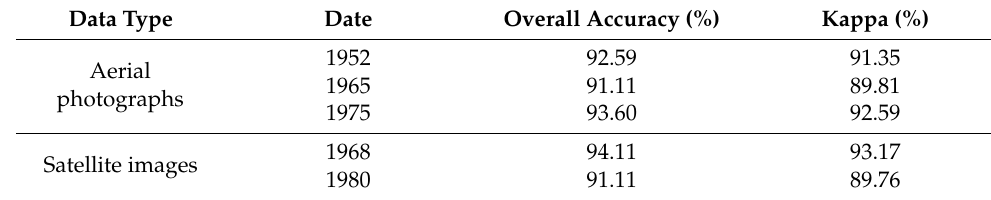
Table 6. The overall accuracy and Kappa statistics of land cover maps of Stamboliyski.